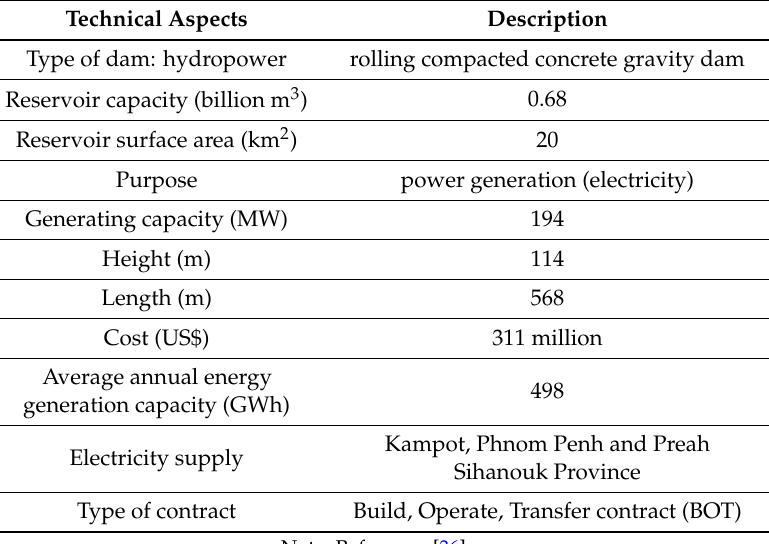
Table 1. Technical details of Kamchay